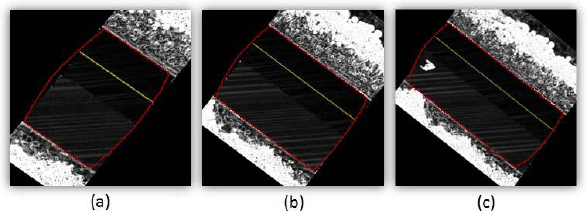
Figure 3: Final position of the snake curve over the slope raster surface with (a) 10m, (b) 20m and (c) 30m road length.